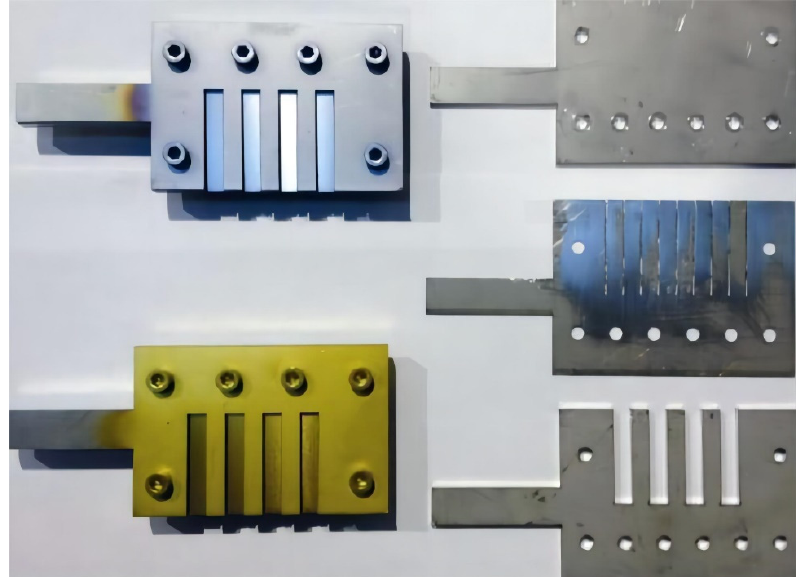
Figure 15. The dummy designed to calculate coating internal stresses: (left) dummies for a AlTiN (up) and TiN (down) coatings; (right) the base, comb-shaped plate and cover just before coating [83].